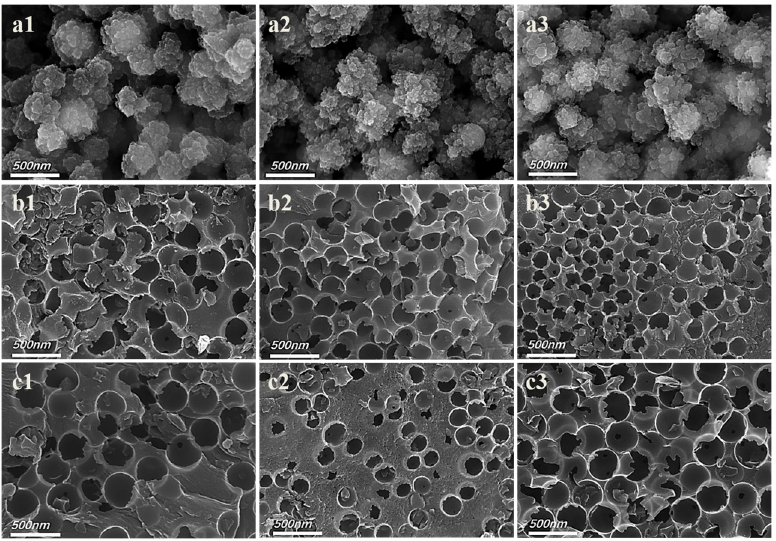
Figure 1. SEM images of SiO 2 @N x P ( a1 – a3 ), BN x C ( b1 – b3 ), and N-BN x C ( c1 – c3 ) (x = 1, 2, 3, corre- sponding to MBA:AM = 1:1, 1:2, 1:3, respectively).